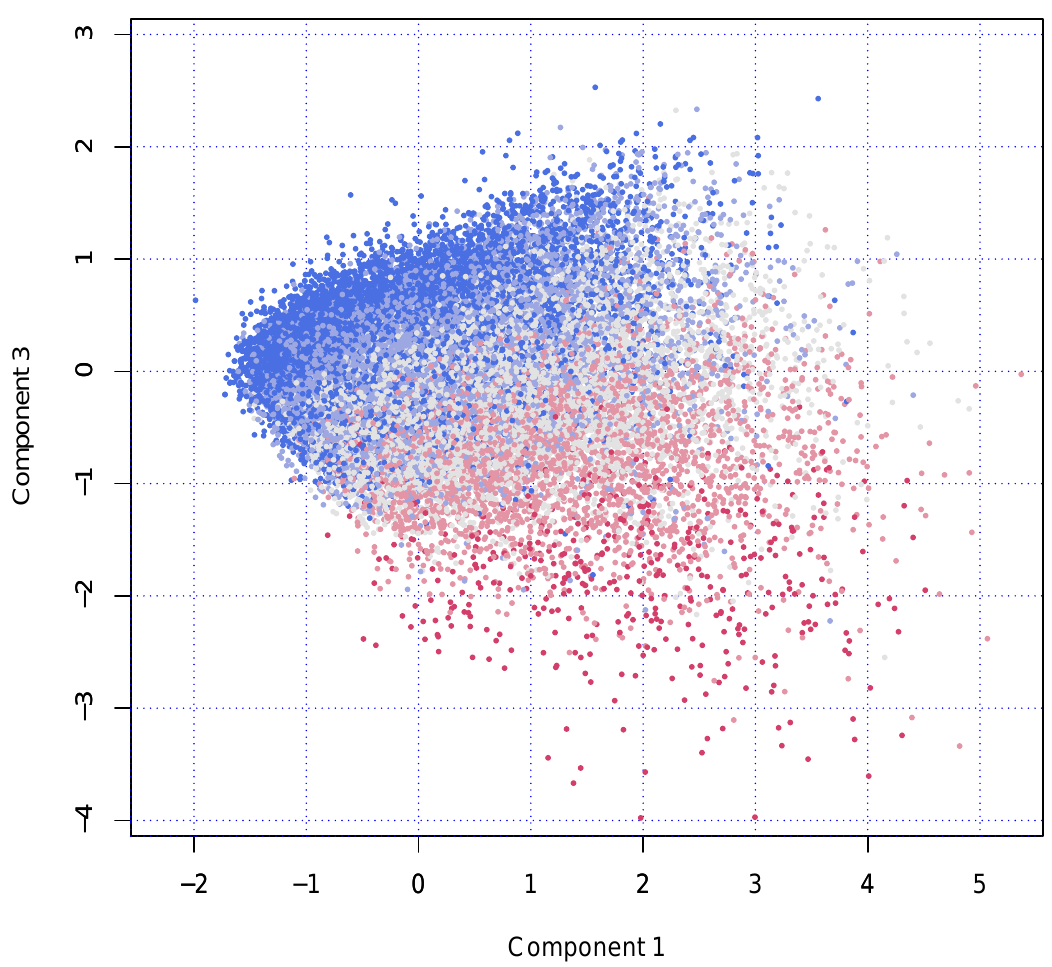
Figure 2. Locations on Components 1 and 3; points are colored according to age group (blue = 50–59 years, red = 80–105 years) (top